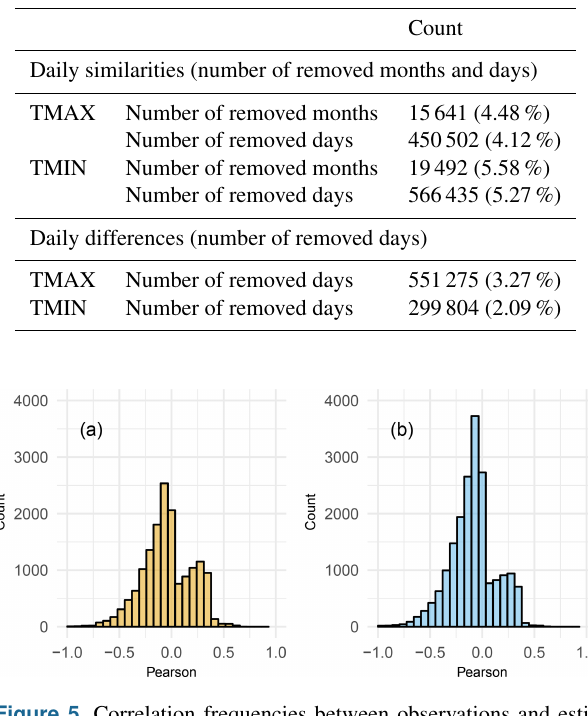
Figure 5. Correlation frequencies between observations and esti- mates of removed data in the quality control process. Maximum (a) and minimum (b) temperatures are